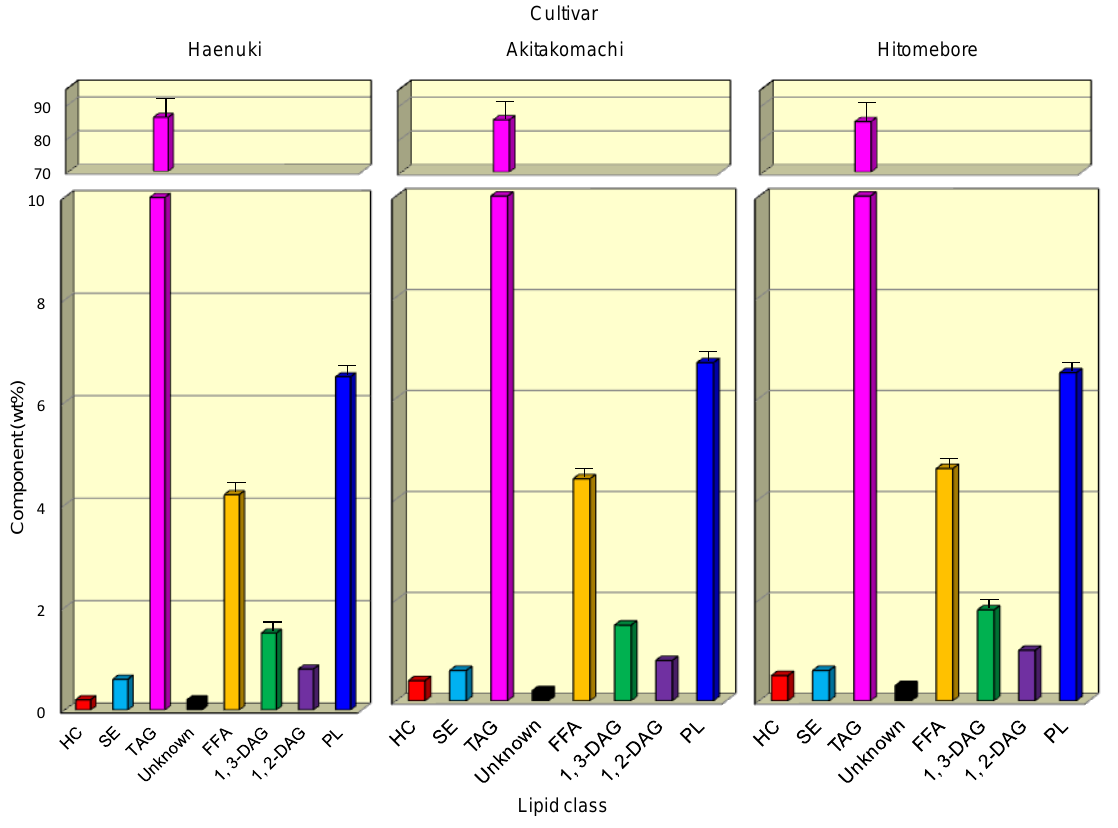
Figure 1. Lipid components in the oils obtained from rice brans of three Japanese cultivars. Each value represents the average of three determinations, and vertical bars depict the mean and standard deviation. HC, hydrocarbons; SE, steryl esters; TAG, triacylglycerols; FFA, free fatty acids; DAG, diacylglycerols; PL,